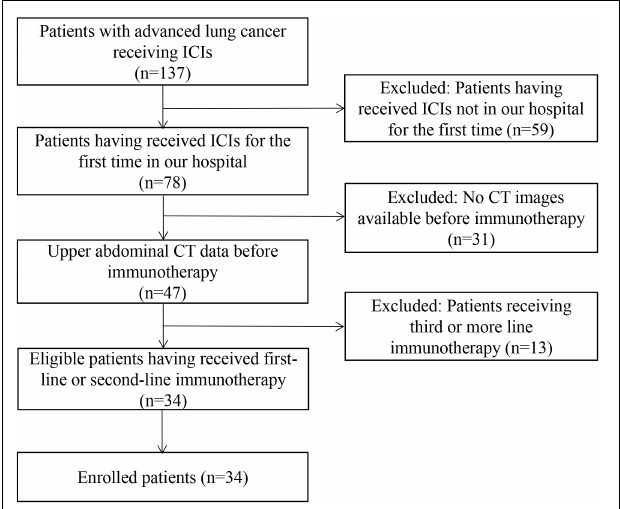
FIGURE 1 | Patient selection flow-chart. ICIs, immune checkpoint inhibitors; CT, computed tomography.